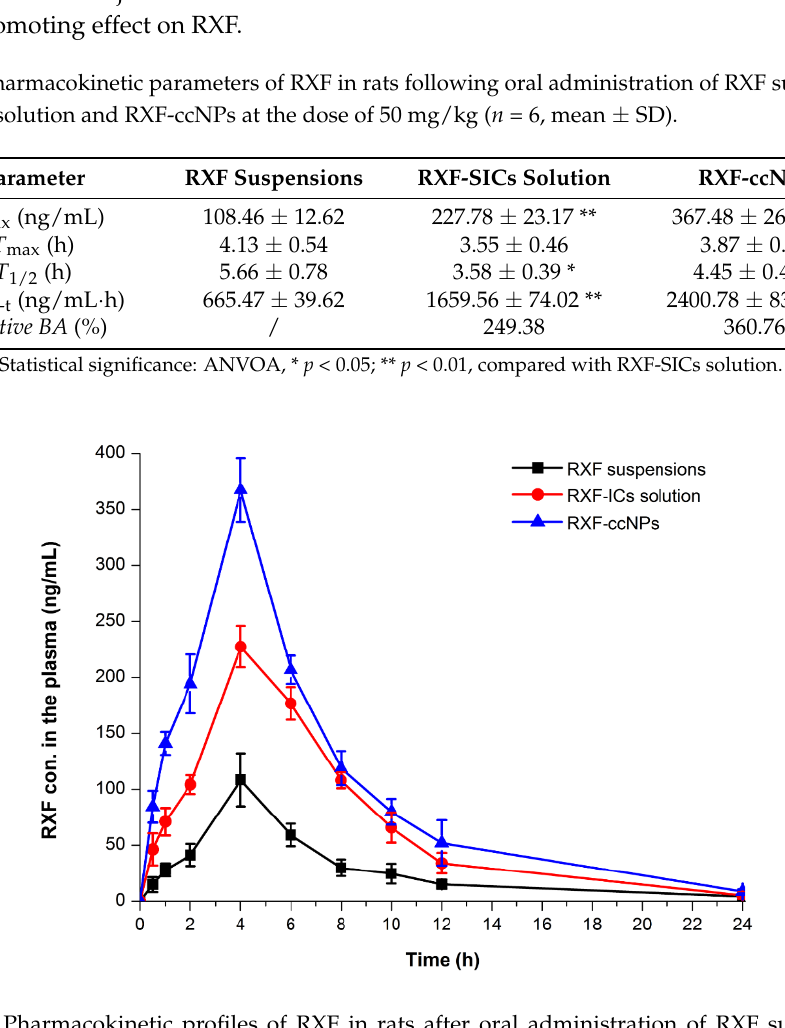
Figure 5. Pharmacokinetic profiles of RXF in rats after oral administration of RXF suspensions, RXF-SICs solution and RXF–ccNPs at a dose of 50 mg/kg ( n = 6, mean ± SD).